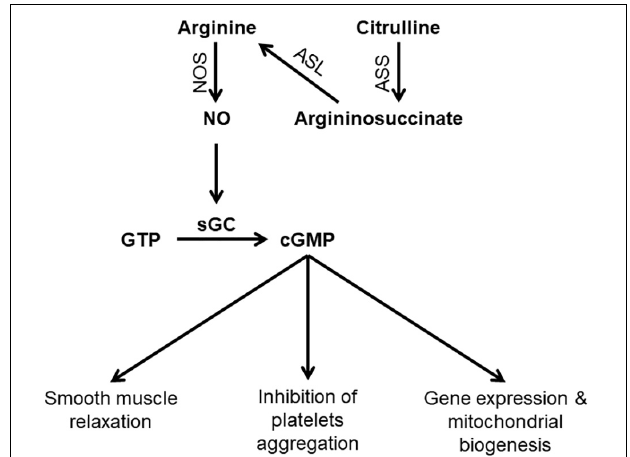
FIGURE 1 | Schematic diagram showing steps in NO synthesis and potential consequences of NO deficiency. ASL, argininosuccinate lyase; ASS, argininosuccinate synthase; cGMP, Cyclic guanosine monophosphate; GTP, Guanosine-5 (cid:48) -triphosphate; sGC, Soluble guanylyl cyclas; NO, nitric oxide; NOS, nitric oxide